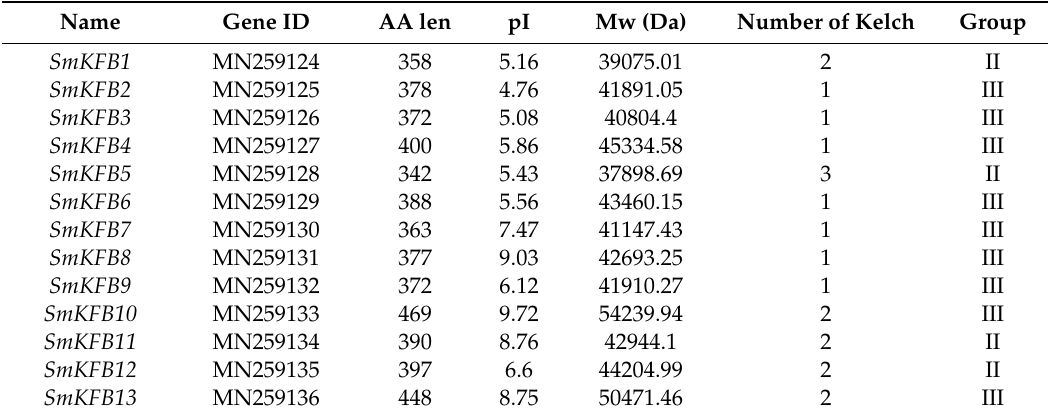
Table 1. Sequence features of SmKFBs in S.